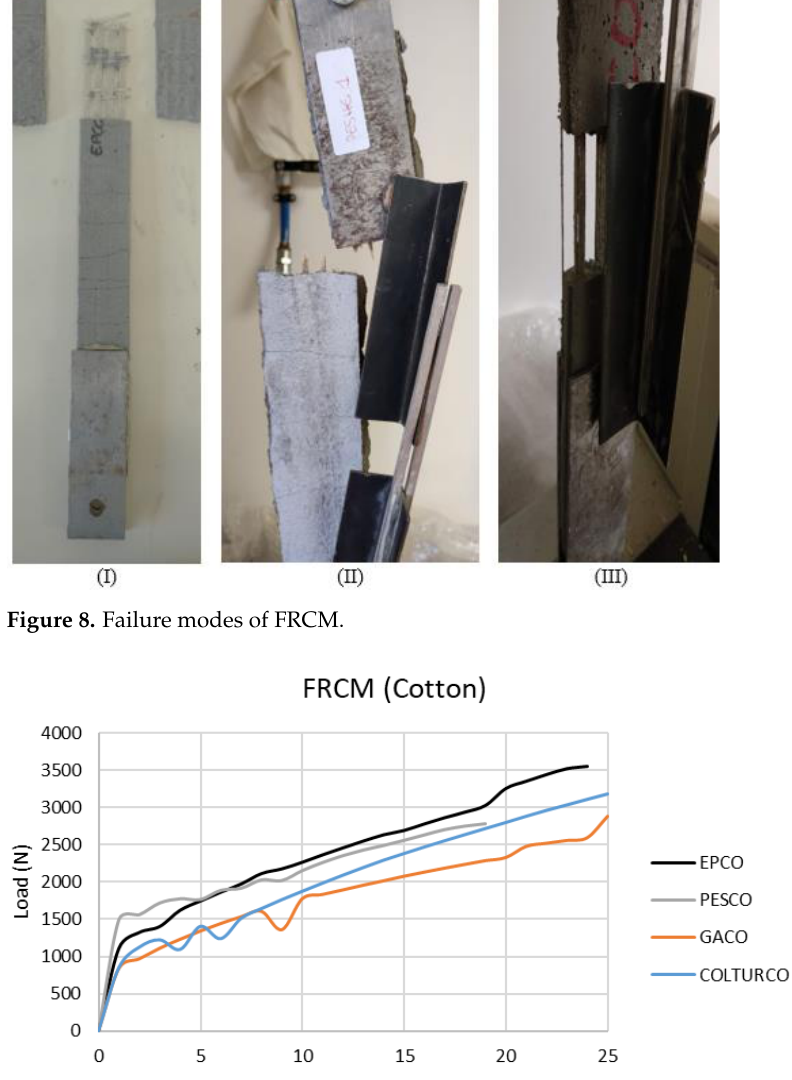
Figure 9. Load–Extensometer curves for cotton FRCM. Figure 9. Load – Extensometer curves for cotton FRCM.